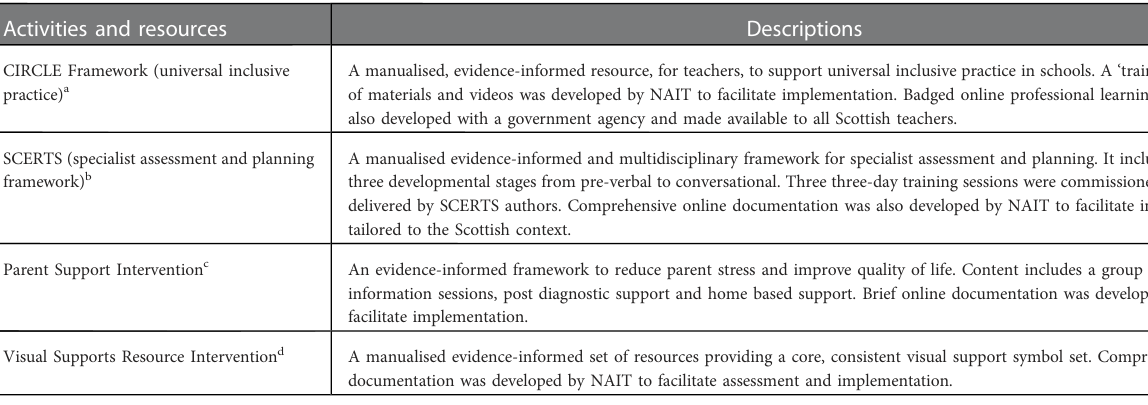
TABLE 4 Pre-existing interventions utilised by